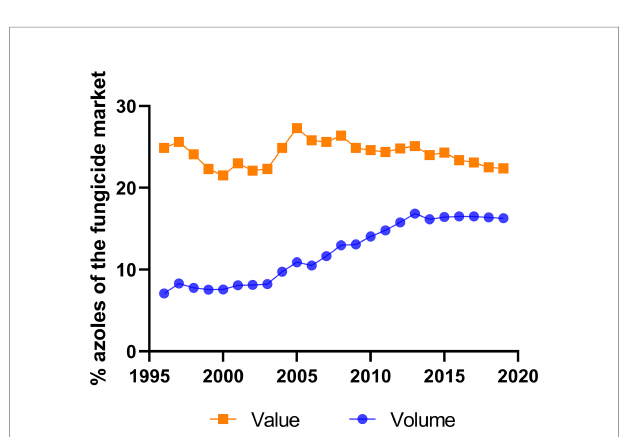
FIGURE 4 | Azoles share of the total fungicide market (%) measured as both volume and market value in different crop segments. Data from 2019 (source: Bayer Internal